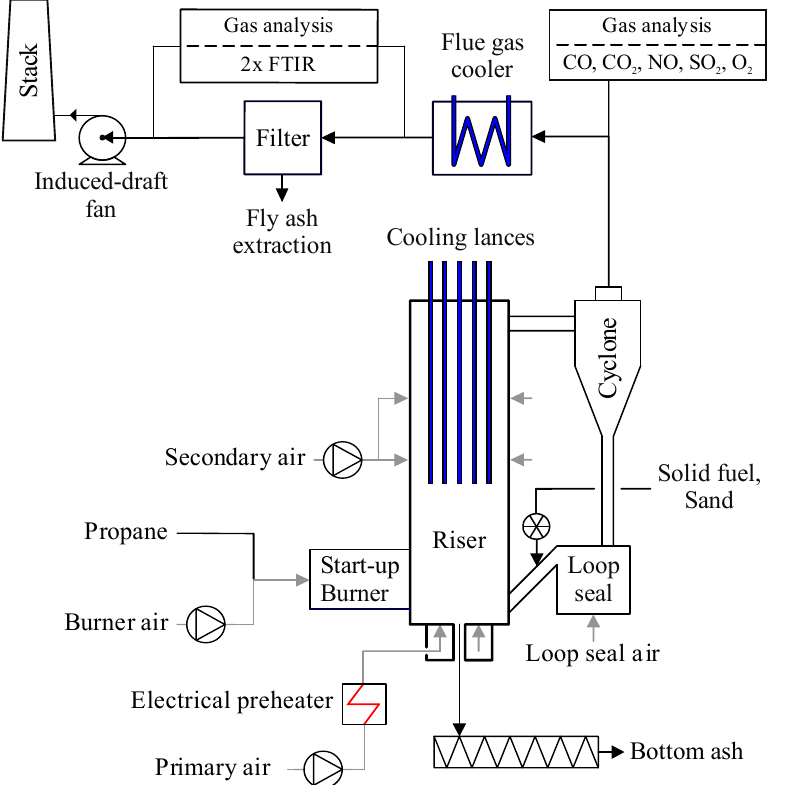
Figure 2. Simplified flow diagram of the 1 MW th pilot plant at the Technical University of Darmstadt.